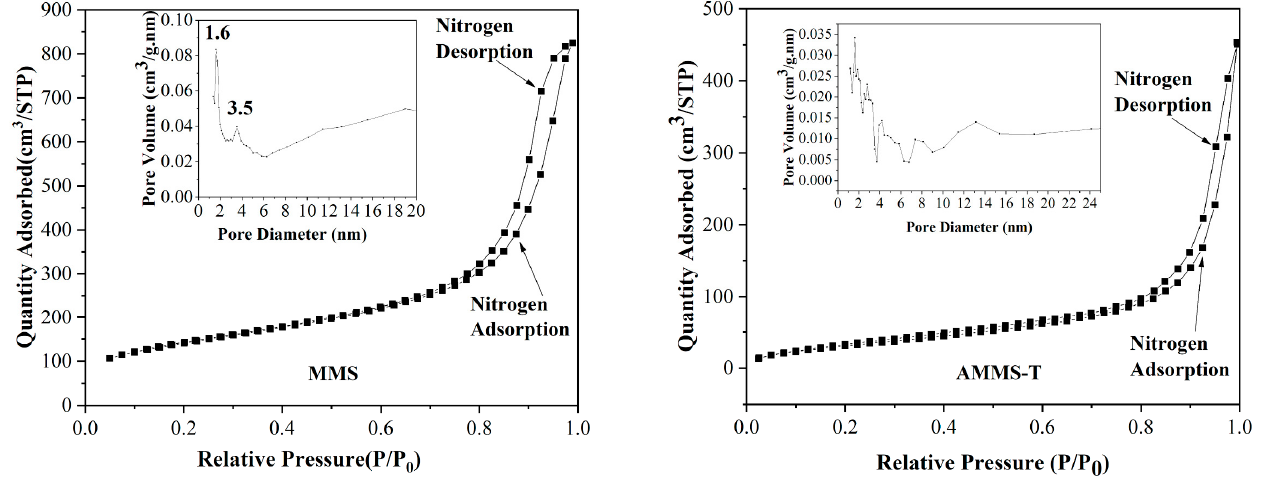
Figure 3. The nitrogen adsorption isotherms of MMS and AMMS-T.